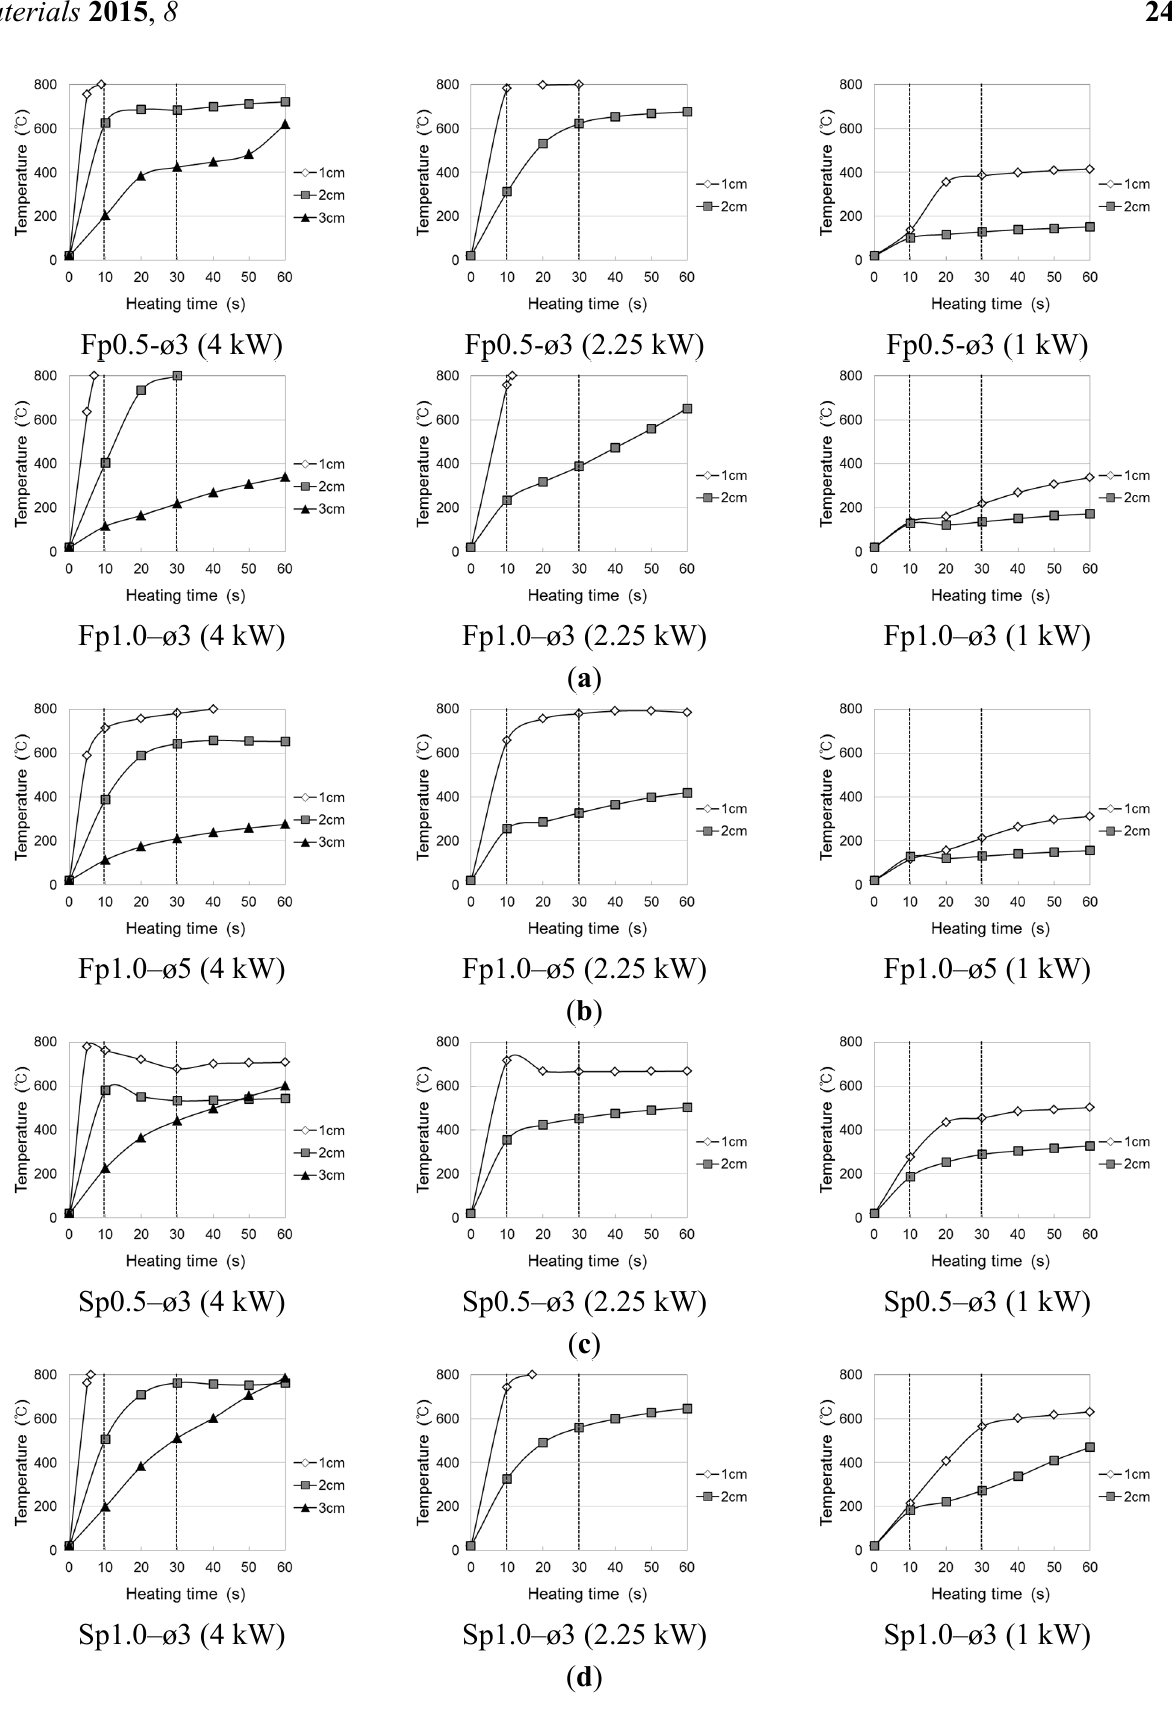
Figure 7. Temperature elevation of conductive resistor (Punching metal). ( a ) Wire punching metal of diameter 3 mm; ( b ) wire punching metal of diameter 5 mm; ( c ) stainless punching metal of thickness 0.5 mm; ( d ) stainless punching metal of thickness 1.0